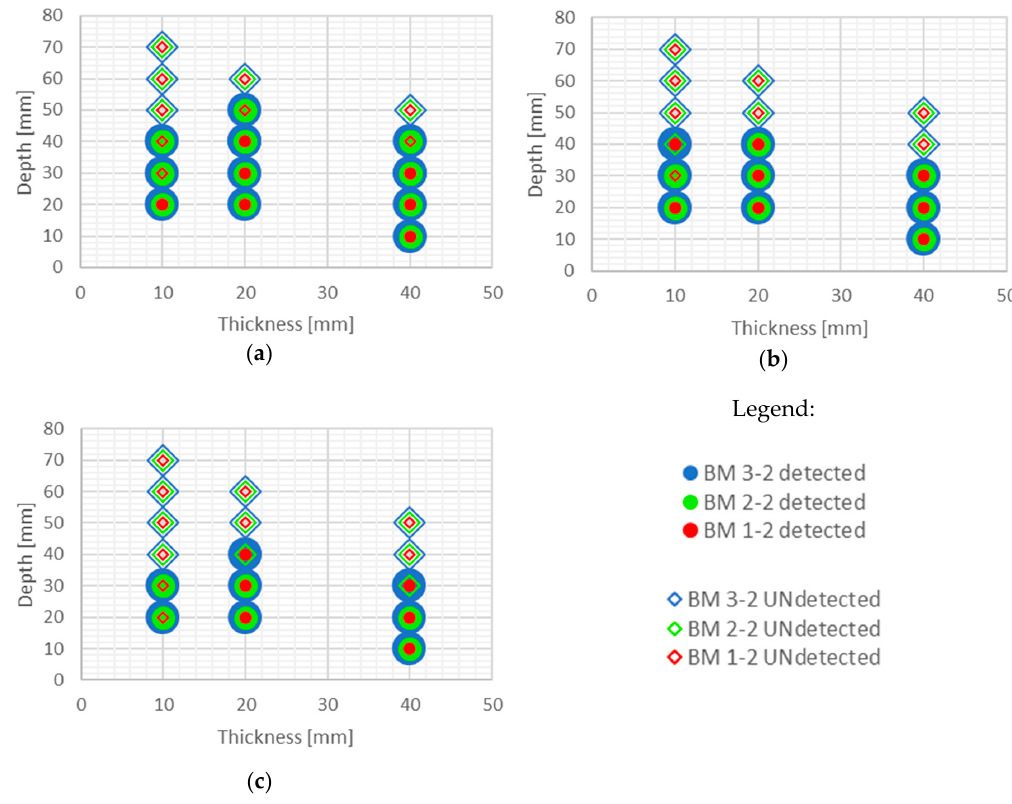
Figure 17. Possibility of defect detection overview for samples BM x-2 (all three concrete types) using PCT: ( a ) excitation distance 1.5 m; ( b ) excitation distance 2 m; ( c ) excitation distance 3